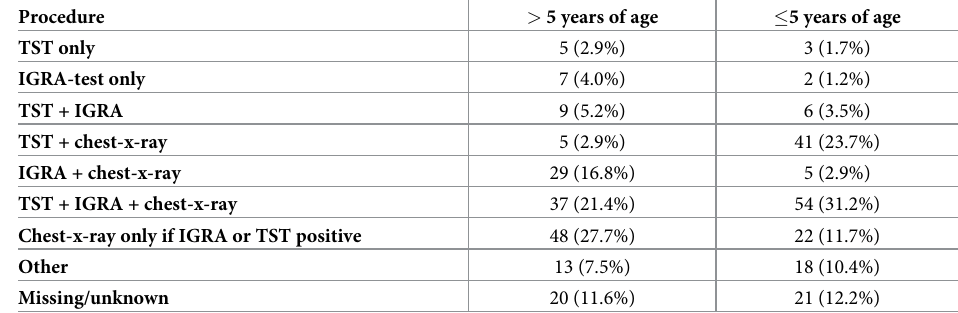
Table 2. Reported diagnostics for LTBI in children older and younger than 5 years of